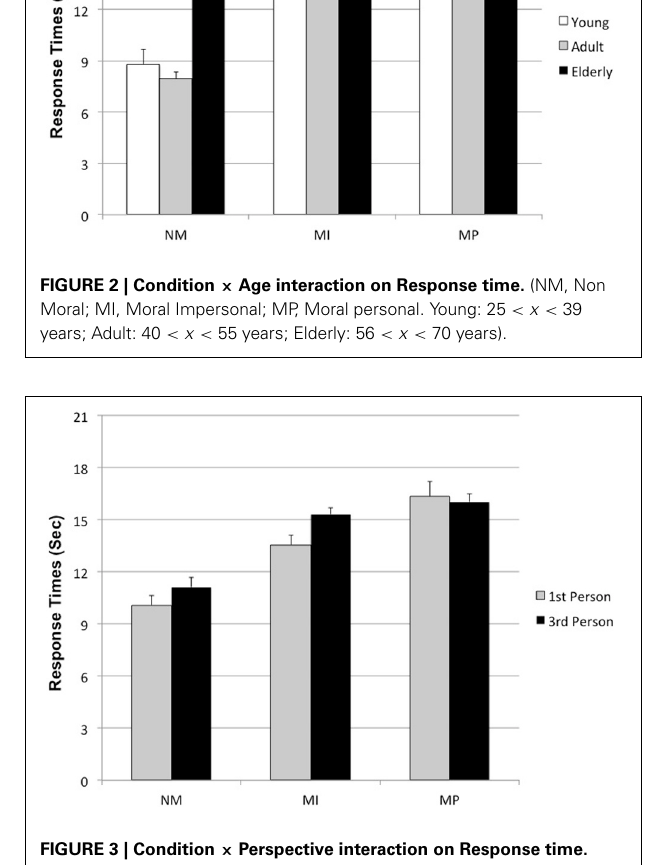
( M = 0 . 01 ± 0 . 007), to MI ( M = 0 . 94 ± 0 . 08) up to MP